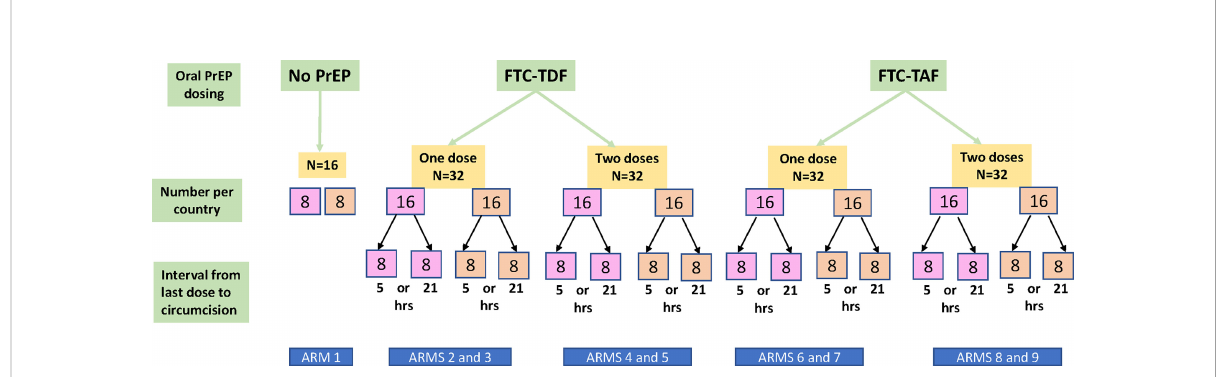
FIGURE 1 Flow diagram of participants in the CHAPS trial. The participants are divided according to PrEP drug (FTC-TDF or FTC-TAF), number of PrEP doses (one or two) and interval between last dose and circumcision (5 or 21 hours). The number of included participants from South Africa is shown in the pink boxes and for Uganda in the orange boxes. Arm 1 consists of control individuals who did not receive PrEP. Each arm includes an equal number of participants from South Africa and from